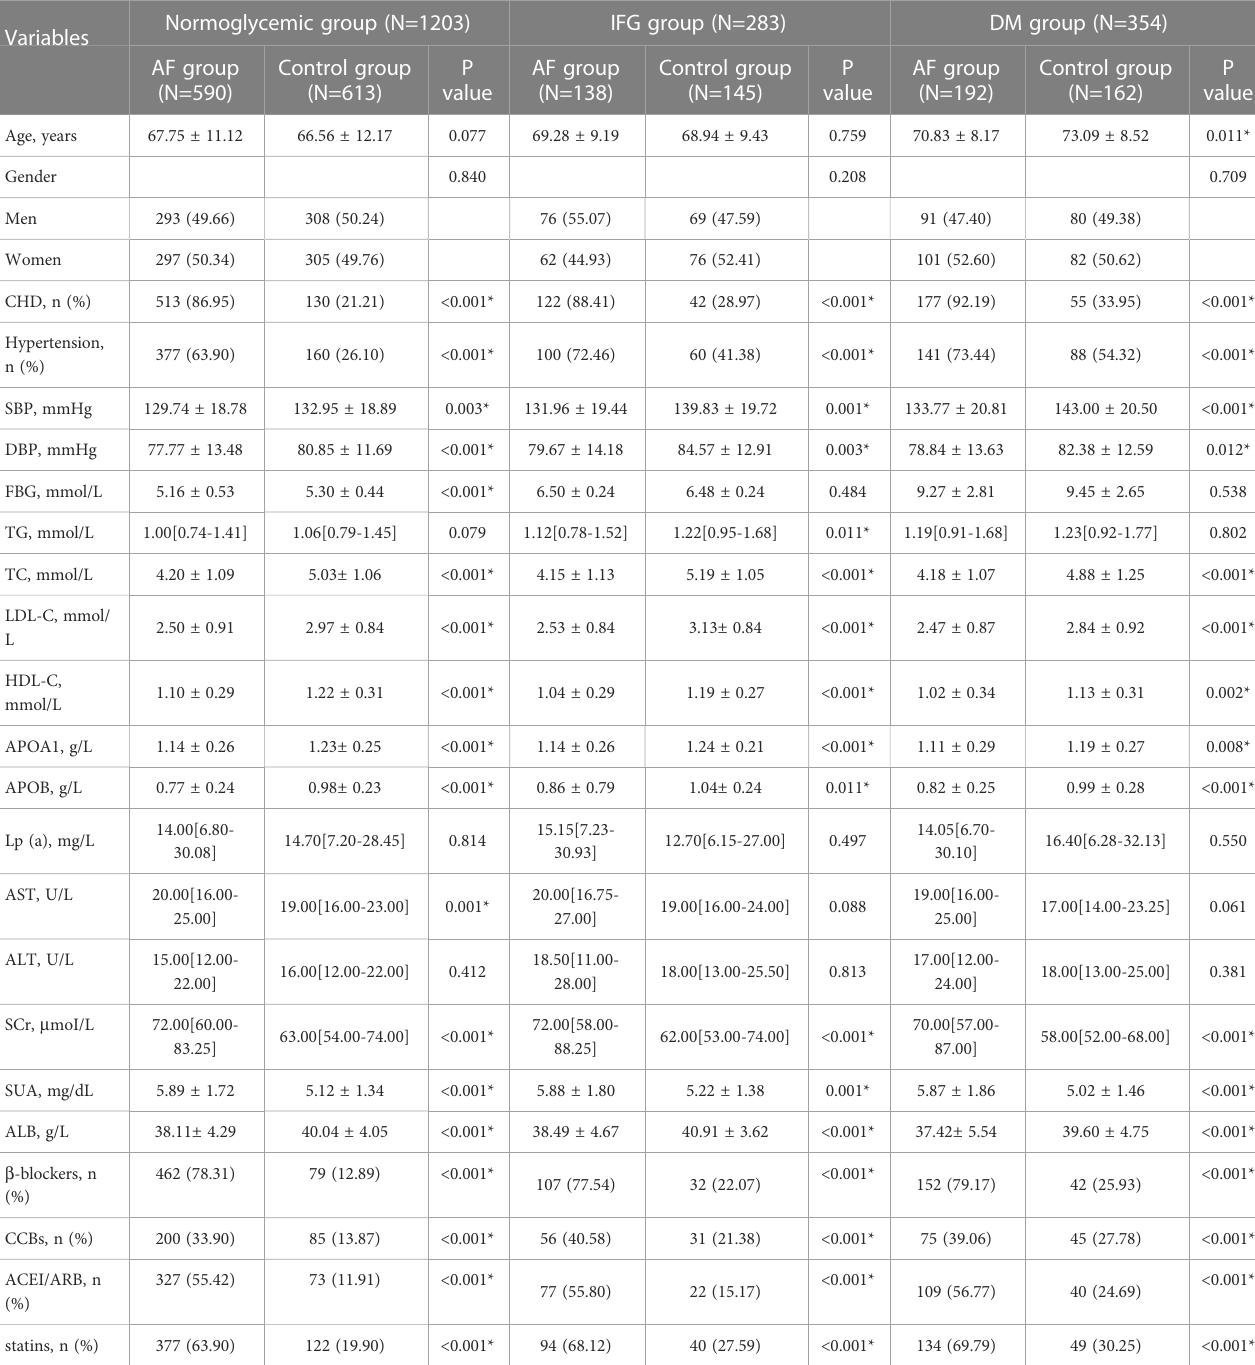
TABLE 1 Baseline characteristics of paroxysmal AF group and